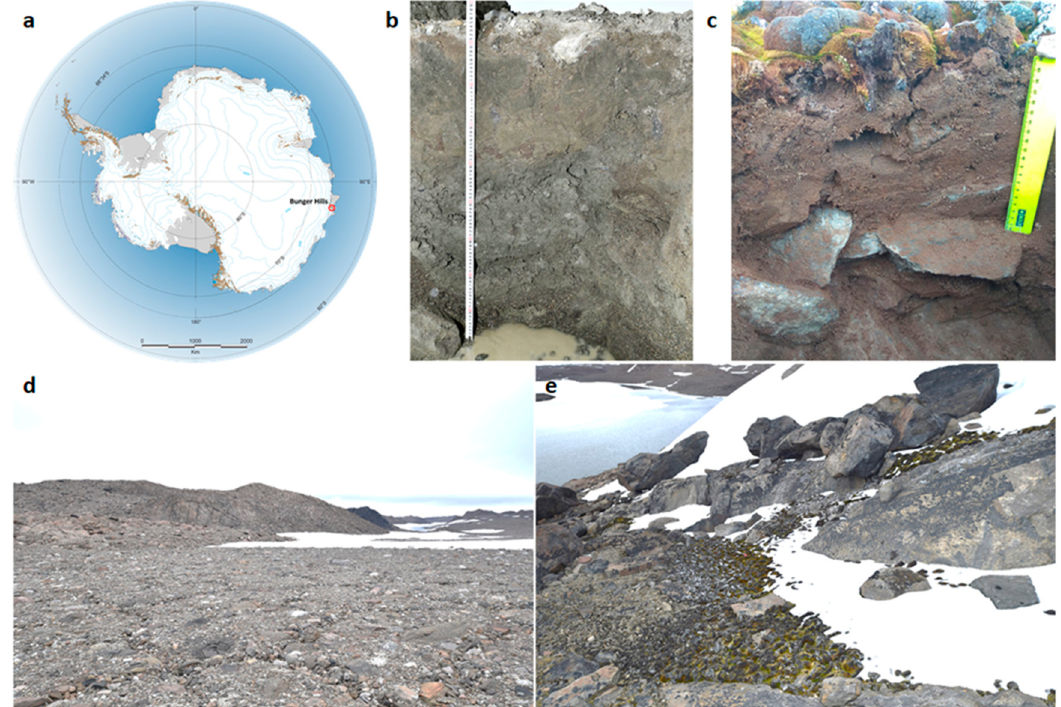
Figure 1. ( a ) Location of Bunger Hills, Eastern Antarctica (relief location map). Soil profiles: ( b )—BB 63–48 (photo by I. Shorkunov), ( c )—BB 63–58 (photo by A. Dolgikh) (see Table 1). ( d )—Typical landscape of the central part of the Bunger Hills, flat valley, the location of the soil BB 63–48 (photo by I. Shorkunov). ( e )—Typical wind shelters with moss cover in the southern part of the Bunger Hills, the location of the soil BB 63–58 (photo by I. Shorkunov). Table 1. Description of the